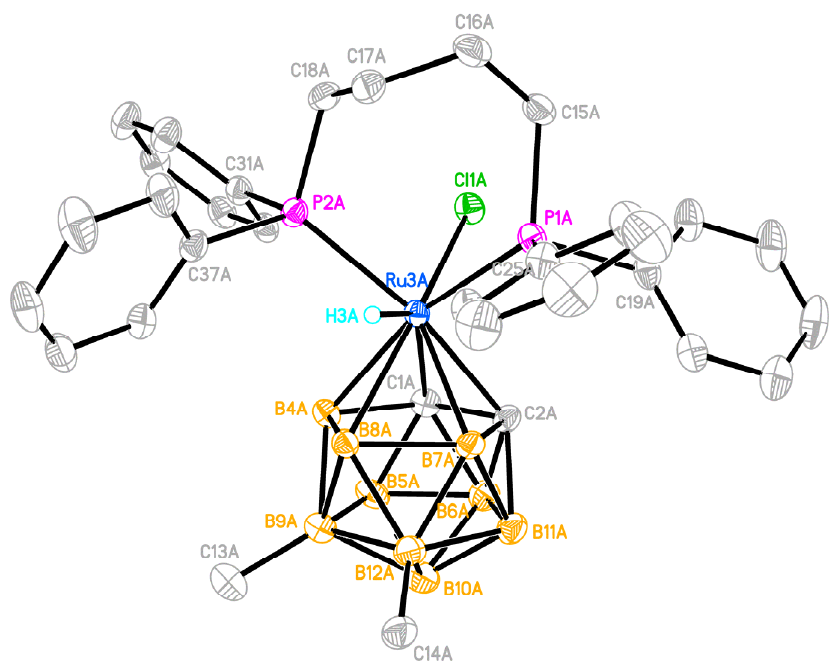
Figure 3. Molecular structure one of two symmetrically independent molecules of ruthenacarborane 4 (thermal ellipsoids drawn at the 50% probability level). Hydrogen atoms except the hydride ligand have been omitted for clarity.